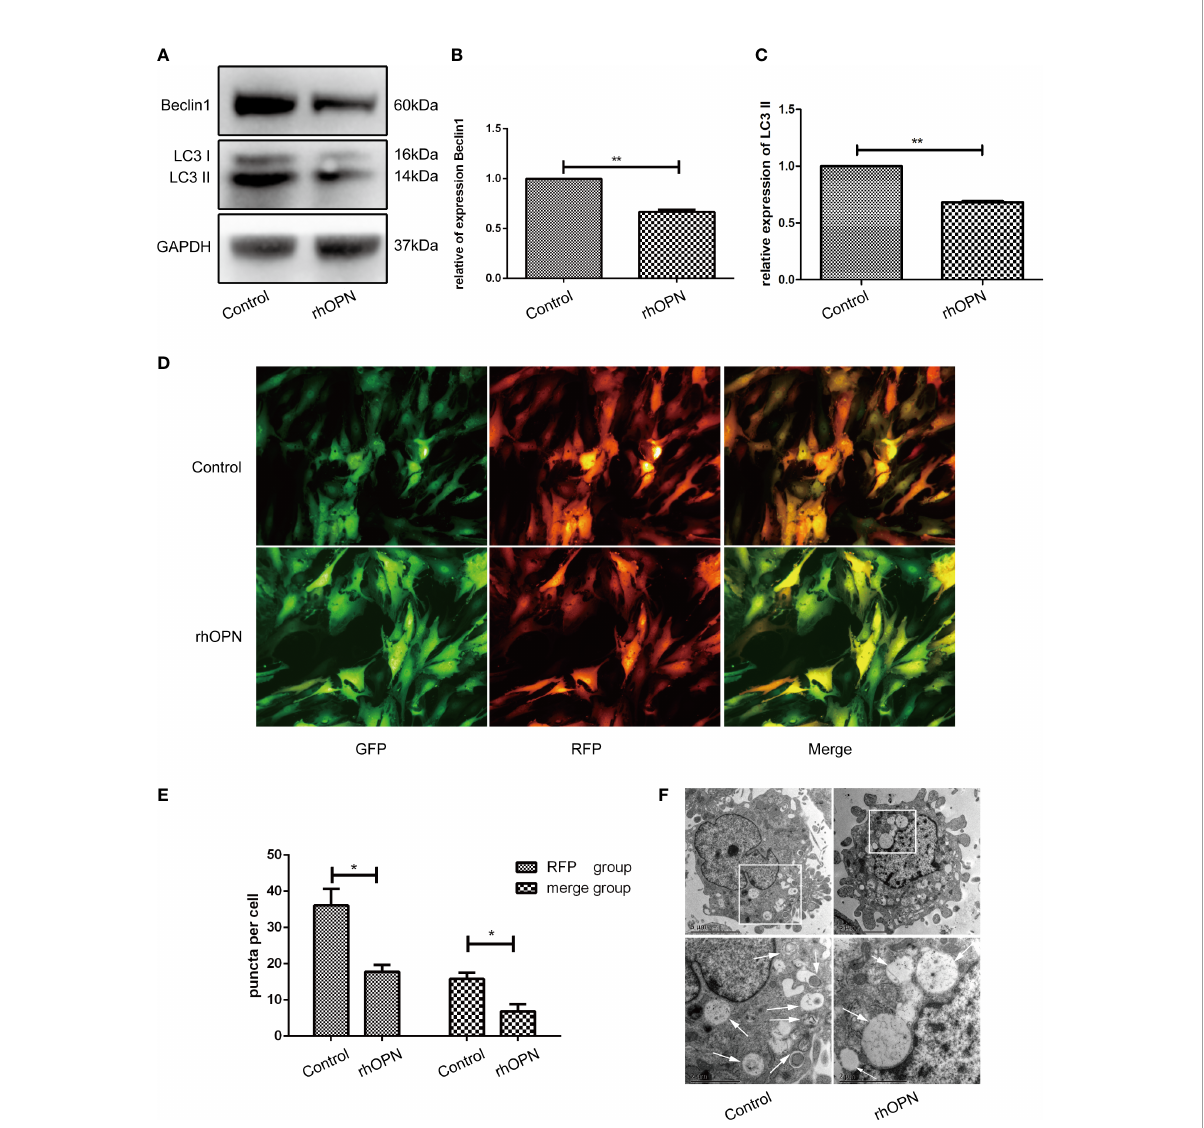
FIGURE 2 (A) Beclin1 and LC3 (both 3 repetitions) were signi fi cantly decreased after treatment with rhOPN in chondrocytes, as shown by western blot analysis; (B) Difference in expression of LC3II between the control and rhOPN groups was statistically signi fi cant (P = 0.0098, P < 0.05, **means P < 0.01); (C) The expression of beclin1 between the control and the rhOPN groups was statistically signi fi cant (P = 0.0049, P < 0.05, **means P < 0.01); (D) mRFP-GFP-LC3 puncta con fi rmed the inhibitory effects of rhOPN on LC3 II; (E) Difference in expression of LC3 between the merge and RFP groups and between the control and rhOPN groups was statistically signi fi cant ( P = 0.0194 and P = 0.0268, respectively, both P<0.05, * means P<0.05). (F) TEM analysis of autophagosomes in chondrocytes under different conditions. Autophagosomes were marked with white arrows. Scale bar: 5